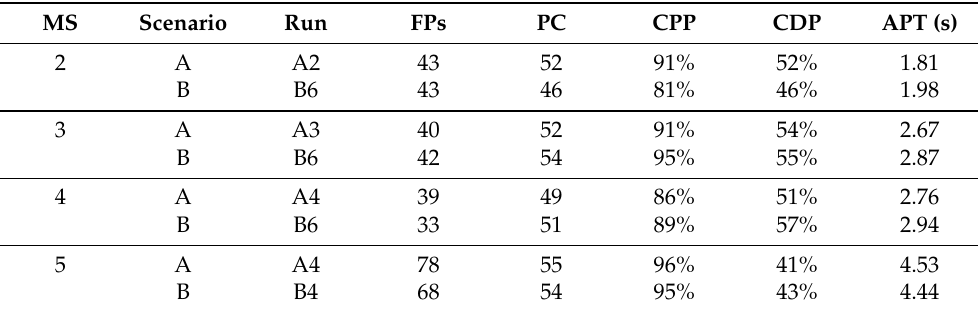
Table 9. Collision prediction summary results. Legend: MS—Multiple steps; FPs—False Positives; PC—Predicted Collisions; CPP—Collision Prediction Percentage; CDP—Correct Decision Percentage; APT—Average Prediction Time